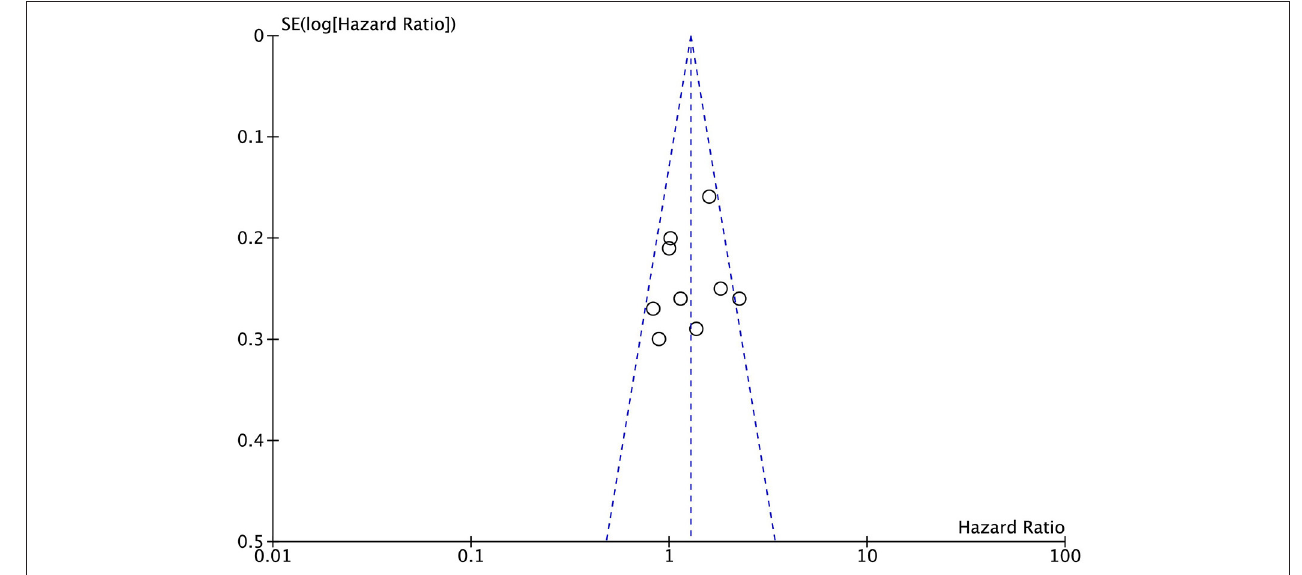
FIGURE 4 | Funnel plot of overall